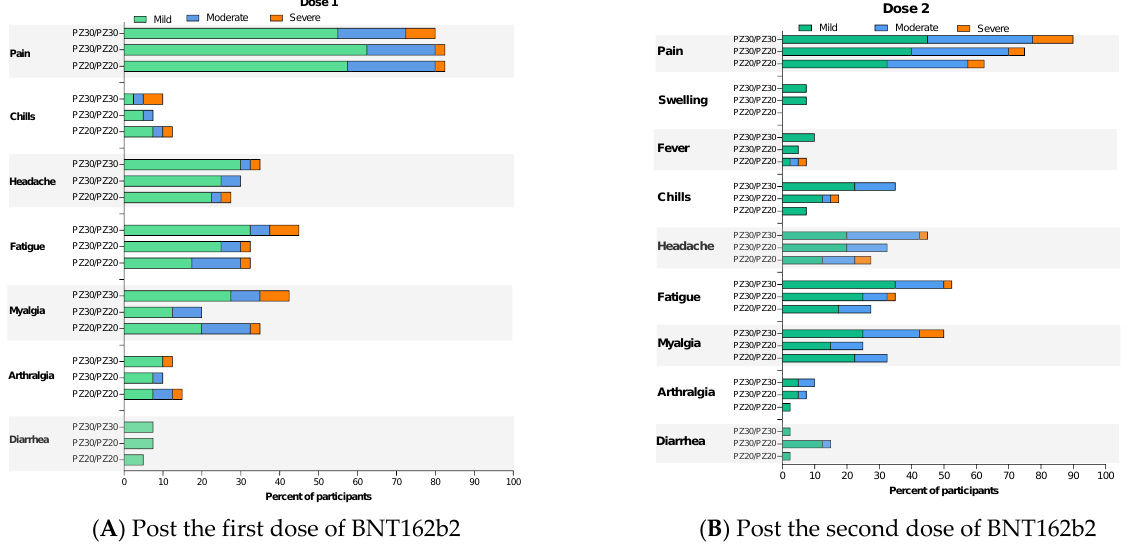
Figure 1. Flow diagram of study participants. * Pos anti-N: positive anti-nucleocapsid IgG; 3wPZ30/30: 3-week interval of BNT162b2 30 µg/30 µg; 3wPZ30/20: 3-week interval of BNT162b2 30 µg/20 µg; 3wPZ20/20: 3-week interval of BNT162b2 20 µg/20 µg; 6wPZ30/30: 6-week interval of BNT162b2 30 µg/30 µg; 6wPZ30/20: 6-week interval of BNT162b2 30 µg/20 µg; 6wPZ20/20: 6-week interval of BNT162b2 20 µg/20 µg; PZ15: booster with BNT162b2 15 µg; PZ10: booster with BNT162b2 10 µg.